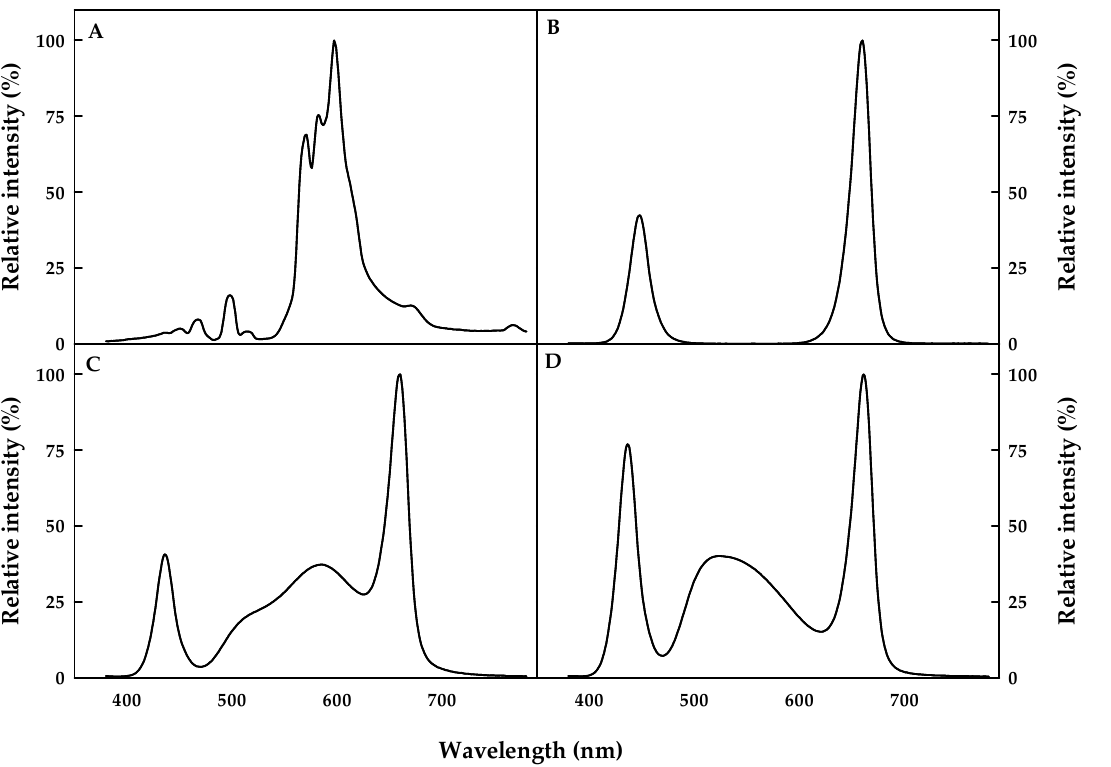
Figure 1. Relative intensity of each SL source. HPS, high-pressure sodium lamps ( A ); NSL, narrow-spectrum LEDs ( B ); SFL1, specific full-spectrum LED 1 ( C ); and SFL2, specific full-spectrum LED 2 ( D ).